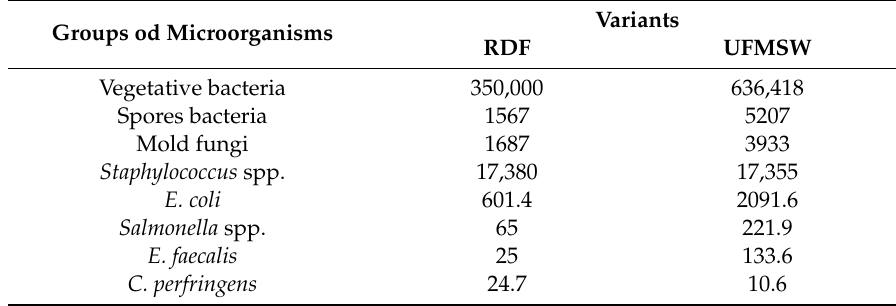
Table 3. Average number (10 2 CFU · g − 1 d.m.) of microorganisms in the control samples (control samples, own